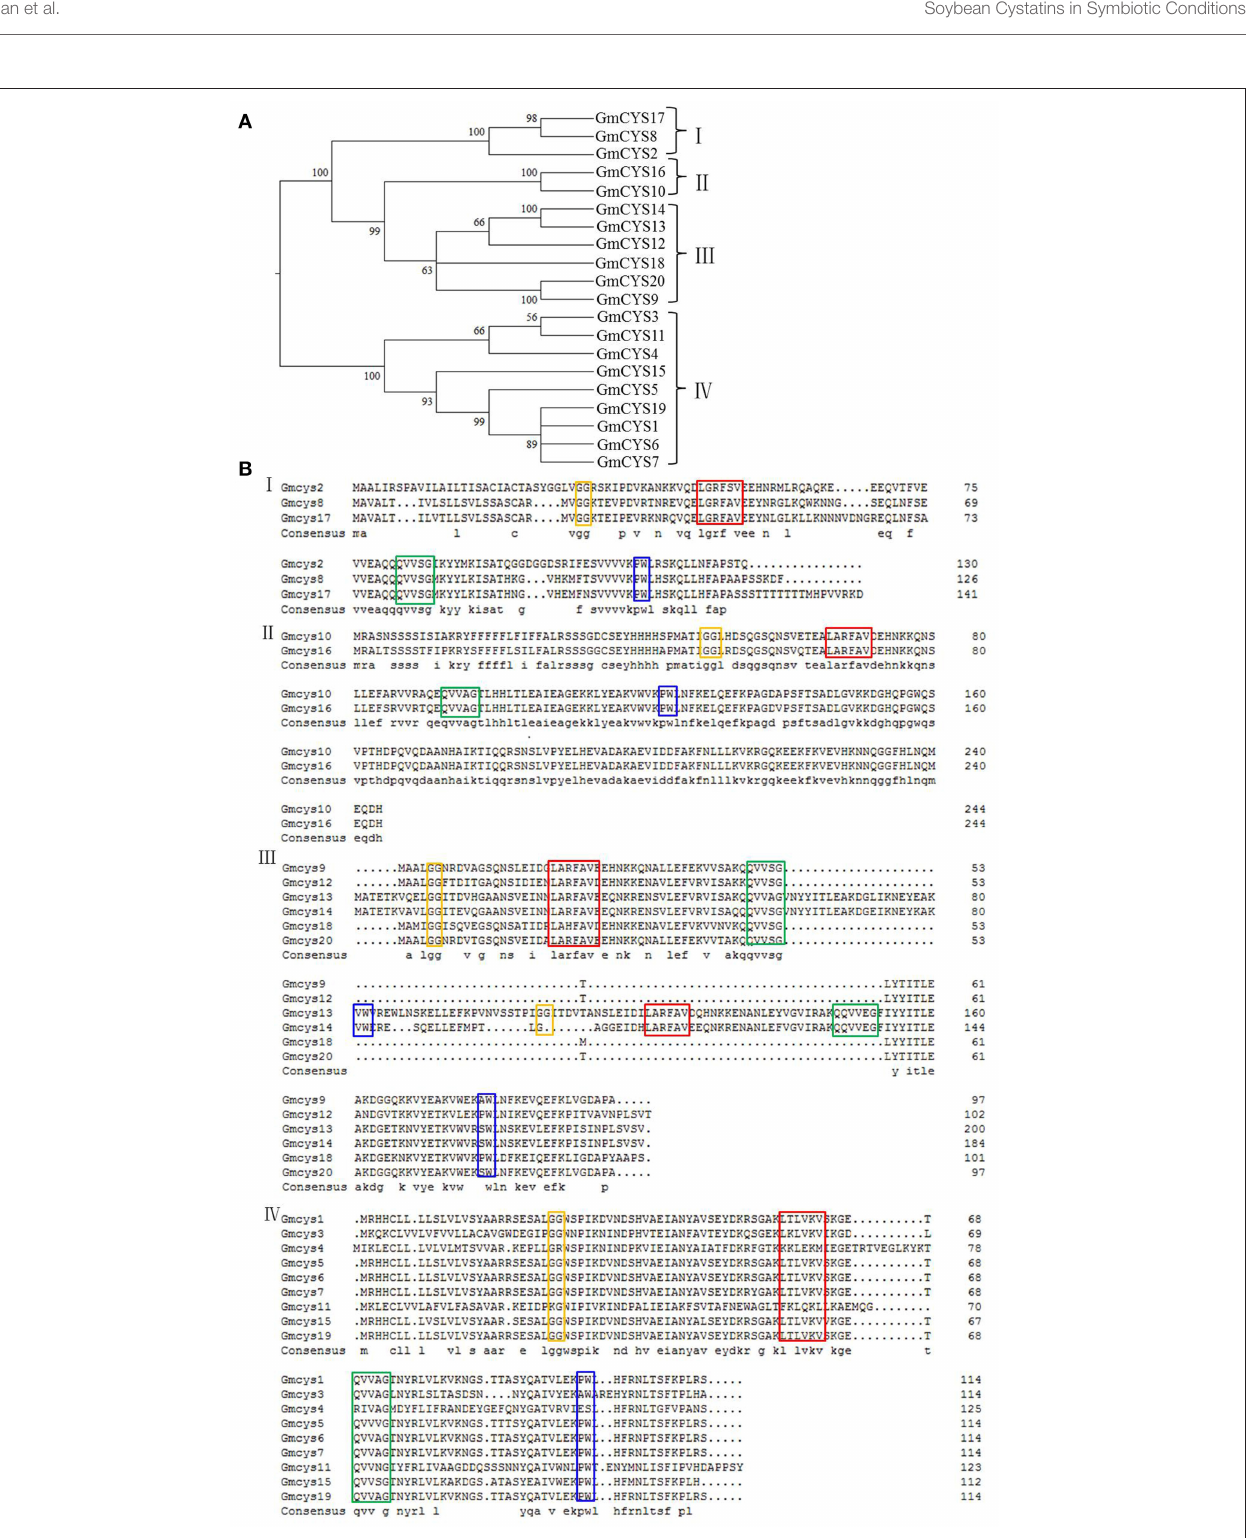
Frontiers in Plant Science |